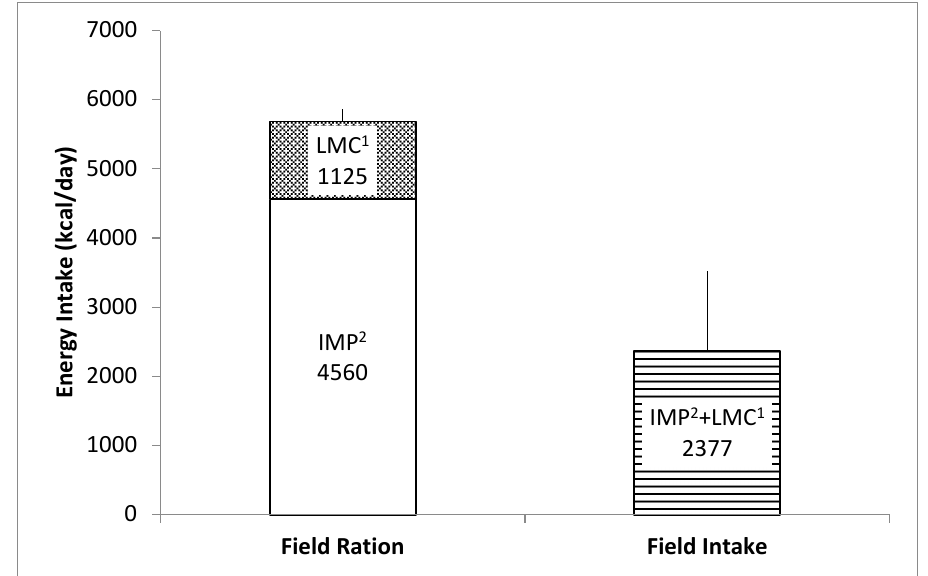
Figure 2. Total energy intake per day available from field rations selected by participants (n = 10) compared to consumed energy intake per day over the four days of dietary intake data collection during the winter weather (arctic-like) training exercise (average temperature − 11 °C, with a minimum of − 22 °C, a maximum of − 2 °C). Field Ration refers to the average energy content available from selected individual meal packs (IMPs) 2 (4560 kcal) and light meal combat (LMC) 1 (1125 kcal) rations (calculated using the nutrient values provided by CAF Directorate Food Services), whereas ration intake (2377 kcal) refers to the energy portion consumed by participants (assessed for 4 days using the measured food intake/food waste collection method). Data presented as means ± standard deviation (SD). Table 2. Energy and macronutrient composition of field rations selected and consumed by study participants (n = 10) 1 .